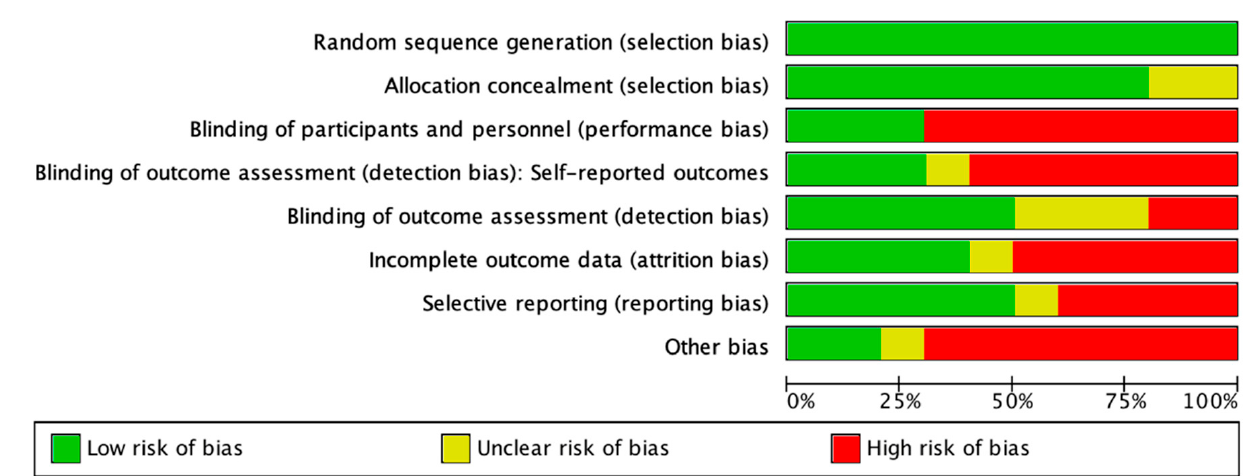
Figure 3. Risk of bias graph: authors’ judgements about each risk of bias item presented as percent- ages across all included studies (n = 10).